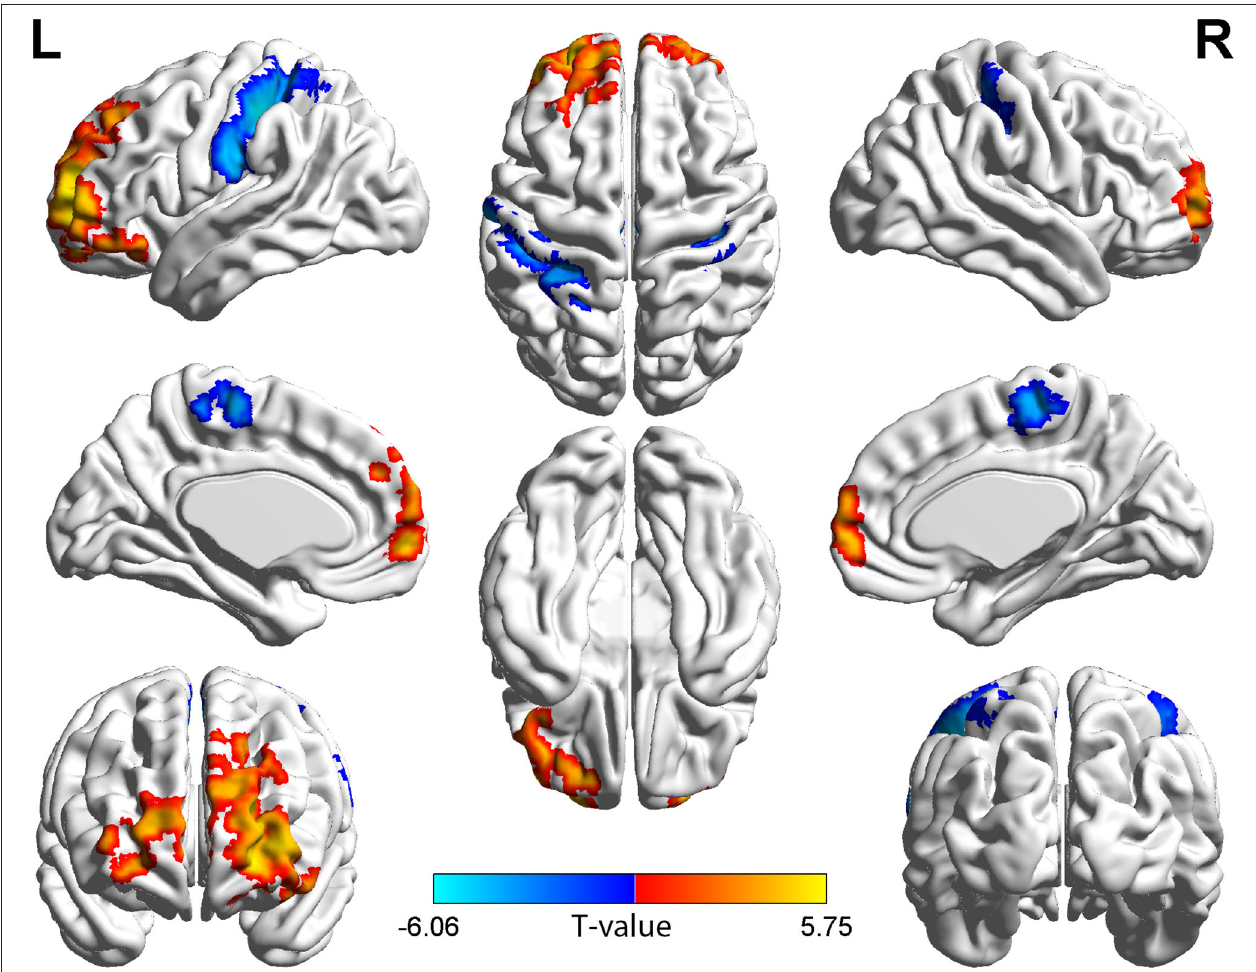
FIGURE 1 | Brain regions with short-range FCD difference between the group with TAO and HCs. Compared with HCs, the group with TAO showed significantly increased short-range FCD in the bilateral SFGdor and SFGmed, left MFG, ORBmid, ORBinf, and ORBsup, and significantly decreased short-range FCD in the bilateral PoCG, left SPG, IPL, PCL, and right SMA (voxel p < 0.001, cluster p < 0.05, cluster-level FWE corrected, cluster size ≥ 109 voxels). The color bar indicates the T- value from two-sample t- tests between the group with TAO and HCs, the warm color denotes relatively higher short-range FCD in the group with TAO, and the cold color denotes relatively lower short-range FCD in the group with TAO. FCD, Functional connectivity density; SFGdor, dorsolateral part of superior frontal gyrus; SFGmed, medial part of superior frontal gyrus; MFG, middle frontal gyrus; ORBmid, orbital part of middle frontal gyrus; ORBinf, orbital part of Inferior frontal gyrus; ORBsup, orbital part of superior frontal gyrus; PoCG, postcentral gyrus; SPG, Superior parietal gyrus; IPL, Inferior parietal; PCL, paracentral lobule; SMA, supplementary motor area; FWE, family-wise